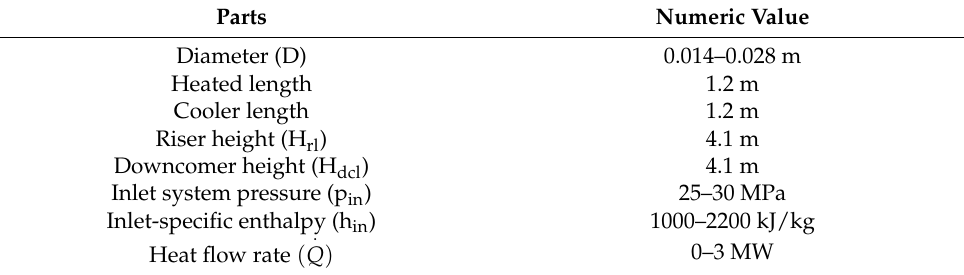
Figure 1. Schematic diagram of HHHC SCWNCL. Table 1. Details of all the parts and operating systems of the SCWNCL [32].